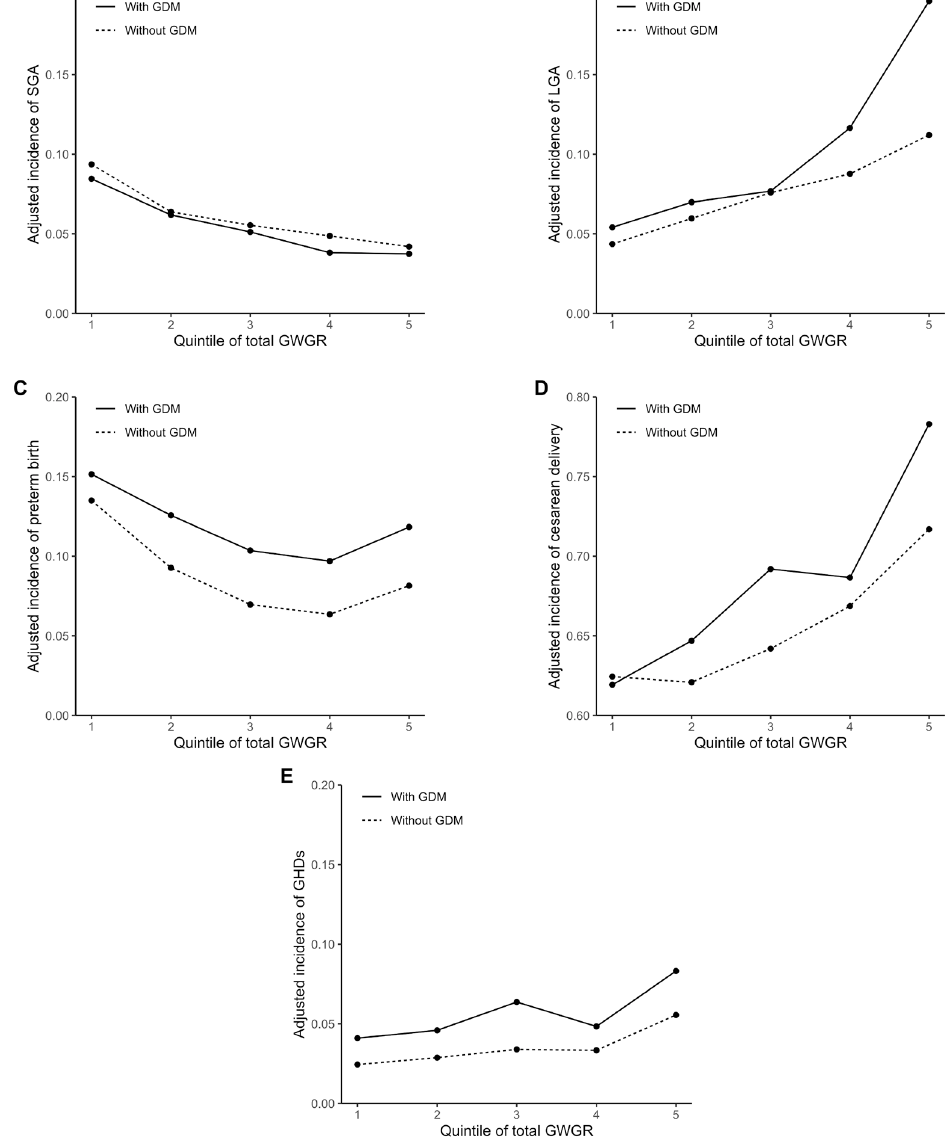
Figure 1. Adjusted incidences of perinatal outcomes with total GWGR: ( A ) adjusted incidence of small size for gestational age (SGA); ( B ) adjusted incidence of large size for gestational age (LGA); ( C ) adjusted incidence of preterm birth; ( D ) adjusted incidence of cesarean delivery; ( E ) and adjusted incidence of gestational hypertension disorders (GHDs). Participants were subdivided into five groups according to the quintile of total GWGR. The adjusted incidences of the perinatal outcomes were estimated by mixed-effects logistic regression with the pre-pregnancy BMI, maternal age, ethnicity, parity, conception mode, and smoking status adjusted and fixed, respectively, at 22.0 kg/m 2 , ≥ 35 and <40 years, Han ethnicity, multipara, natural conception, and nonsmoking, for both women with and without GDM (mean or most frequent category of the